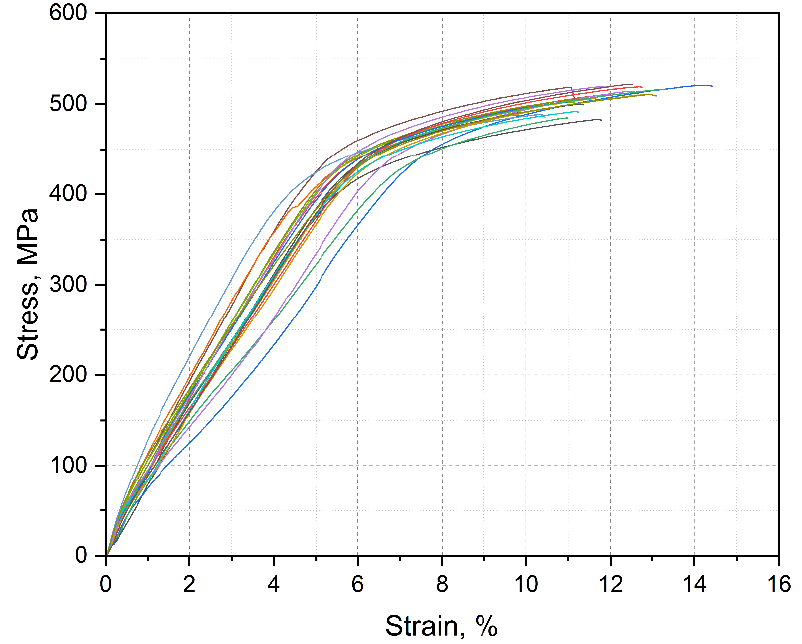
traces can be seen, which were only slightly deep in the longitudinal section.